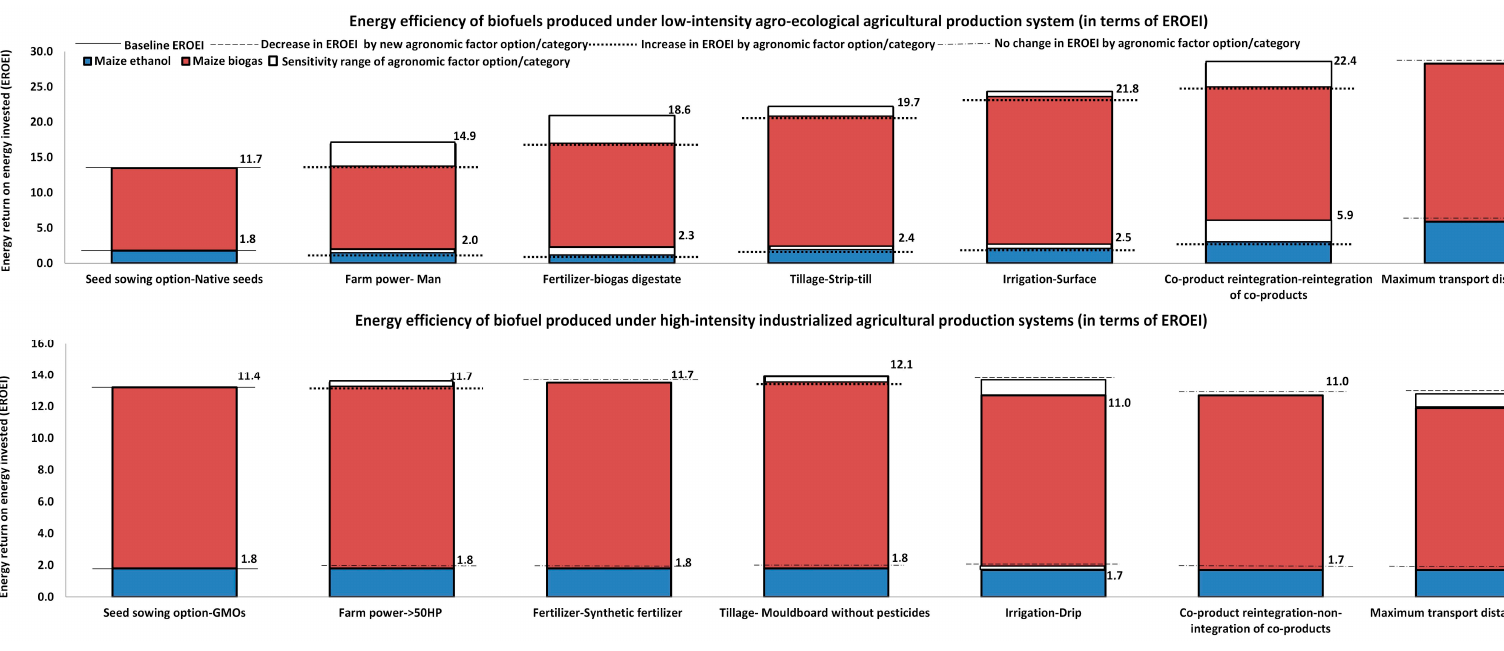
Figure 4. Comparison of the energy efficiency of biofuels produced under alternative agricultural production systems, i.e., high-intensity industrialized agricultural systems and low-intensity eco-agricultural production systems (in terms of EROEI).